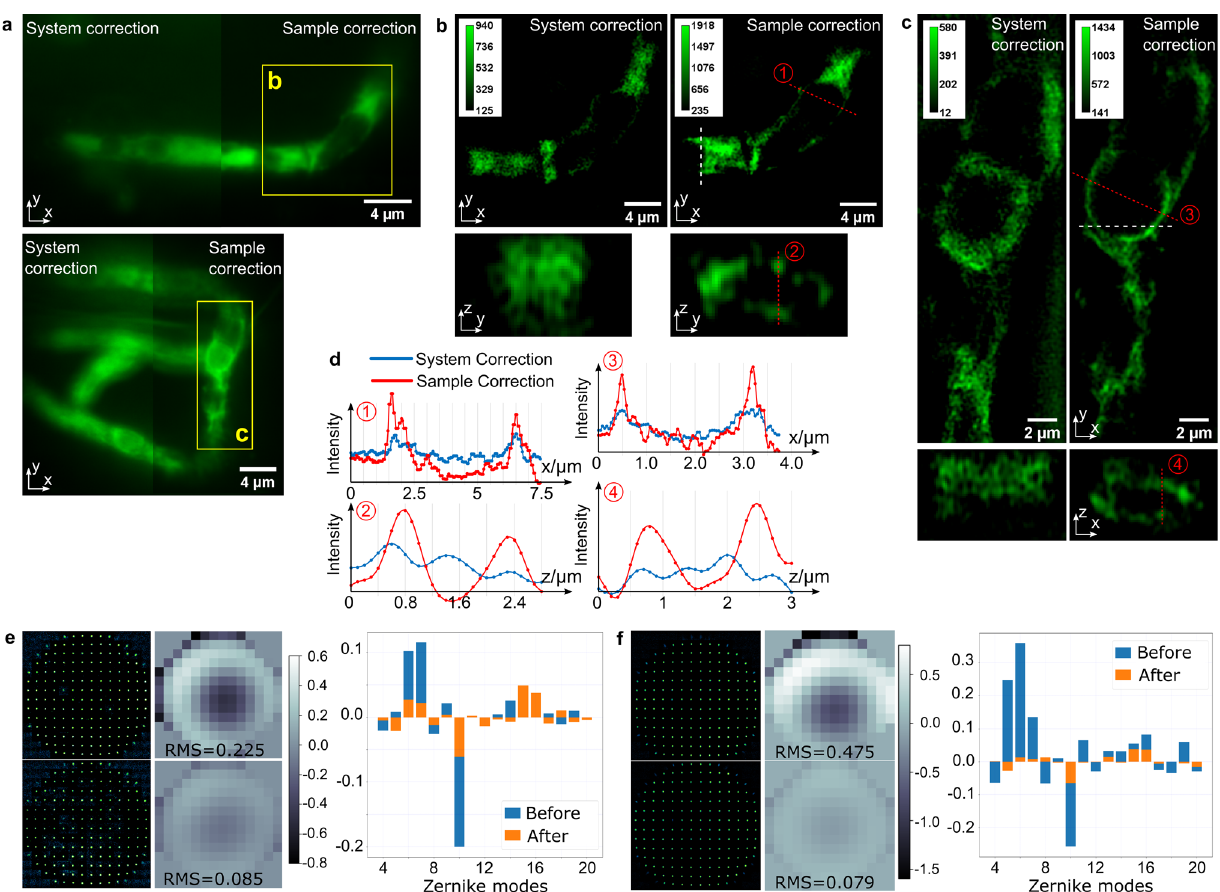
Fig. 9 GFP-labeled endoplasmic reticulum of live M. oryzae hyphal cells growing inside rice plant cells. a Wide fi eld images of ER before (left) and after (right) sample aberration correction. b 3D-SIM image of ER inside square area b before (left) and after (right) sample aberration correction and the cross section cut through the white dashed line. c 3D-SIM image of ER inside square area c before (left) and after (right) sample aberration correction and the cross section cut through the white dashed line. d Intensity pro fi les plotted across the four red dashed lines. e The measured wavefronts of area b, and their Zernike mode decompositions before and after sample aberration correction (units in microns). f The measured wavefronts of area c and their Zernike modes decompositions before and after sample aberration correction (units in